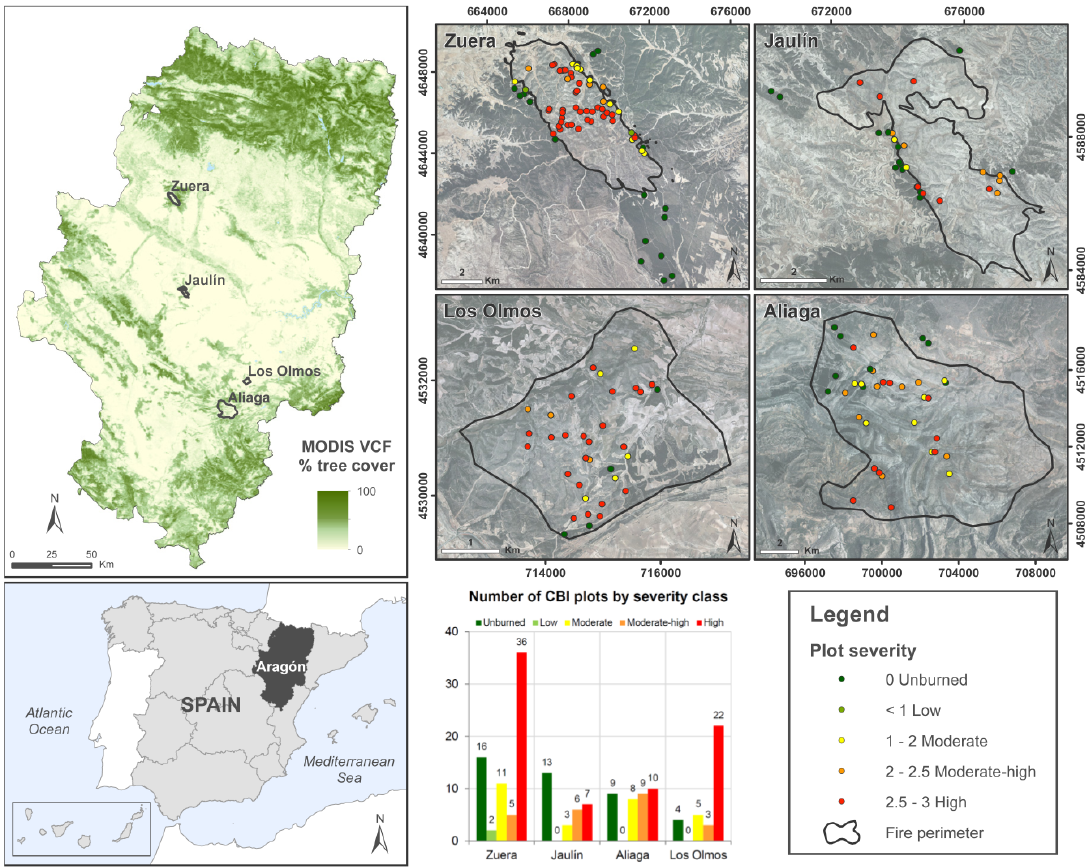
Figure 1. Study area and Composite Burn Index (CBI) field plots location. MODIS vegetation fractional cover (VFC) images and high spatial resolution ortophotography (PNOA-2012) are used as